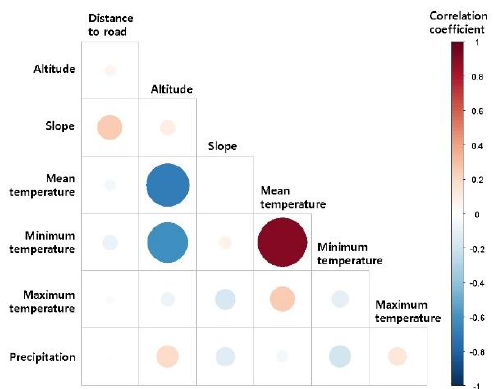
Figure 3. Correlation coefficient between environmental variables measured at 210 presence or absence sites.